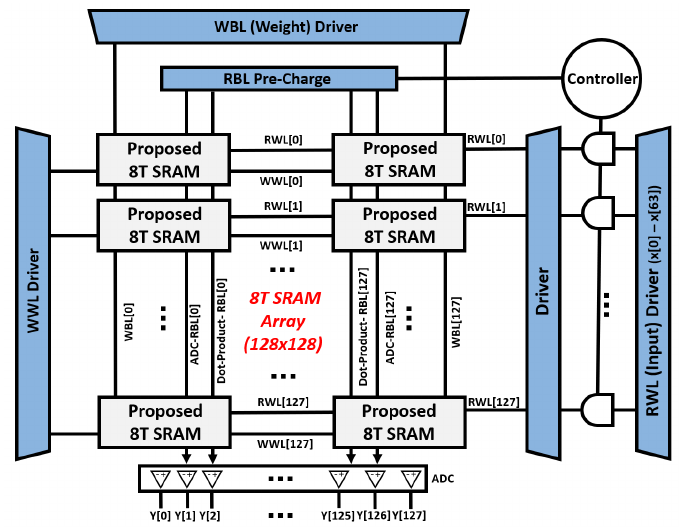
Figure 5. Overall architecture of the proposed 16K SRAM-CIM (64 × input and 128 ×